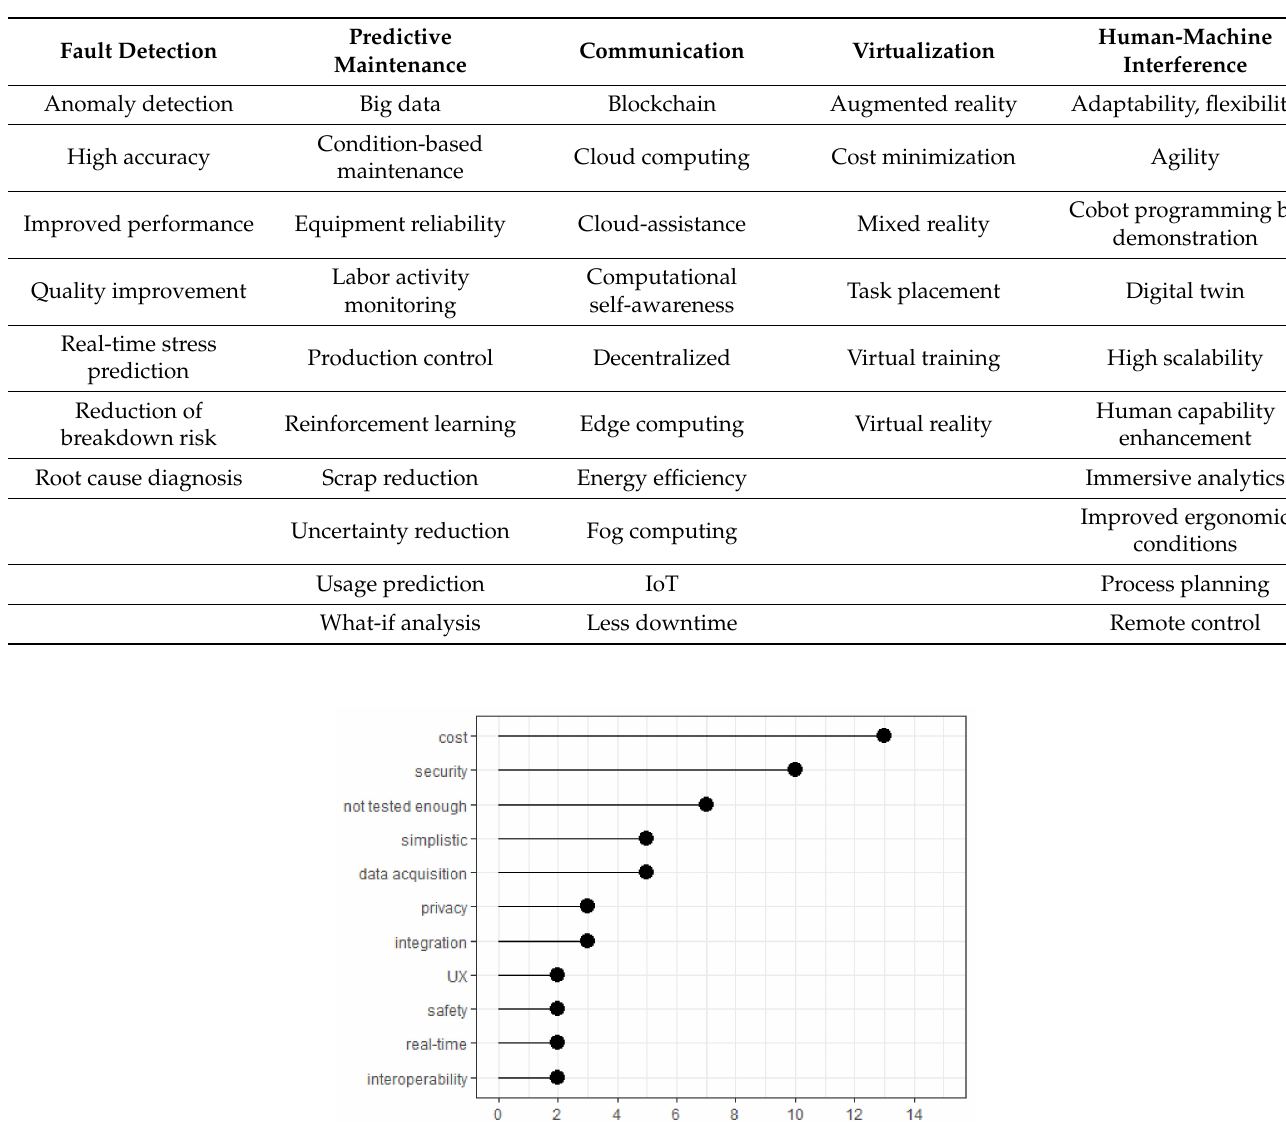
Table 3. Features identified in articles.